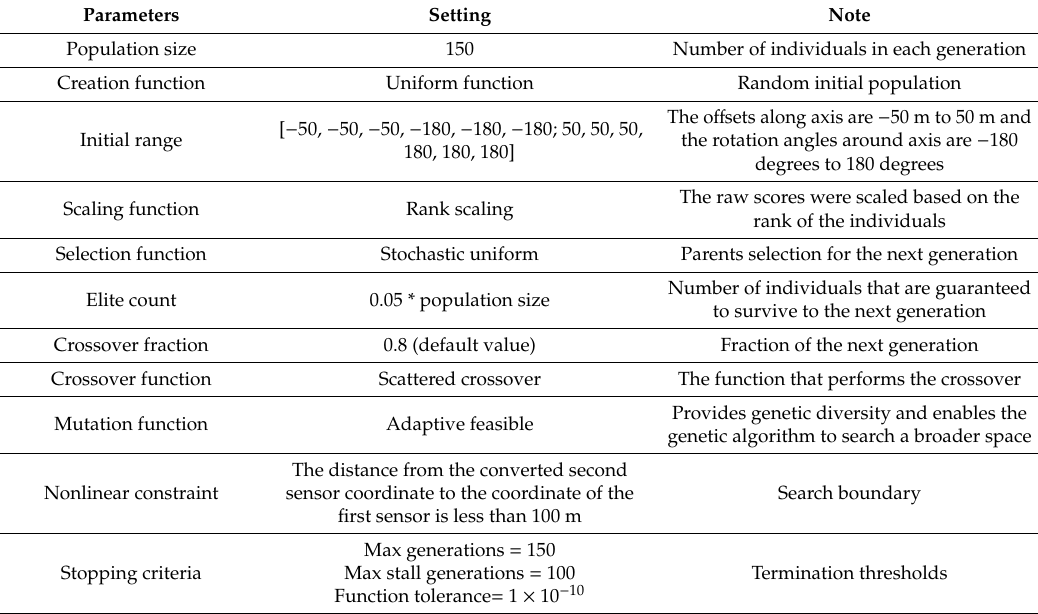
Table 1. Parameters in GA.